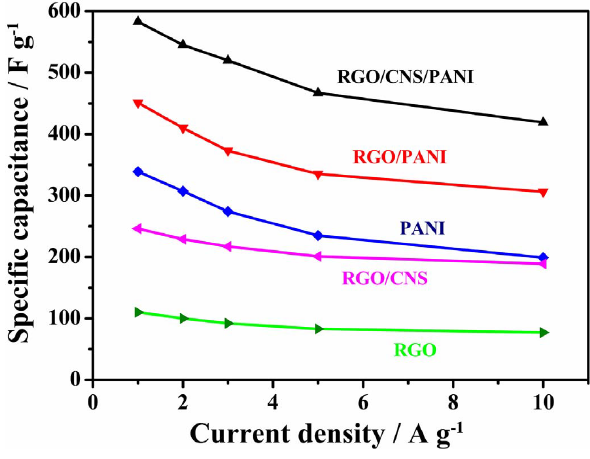
Figure 11: Specific capacitances of RGO, RGO/CNS, PANI, RGO/PANI and RGO/CNS/PANI at different current densities